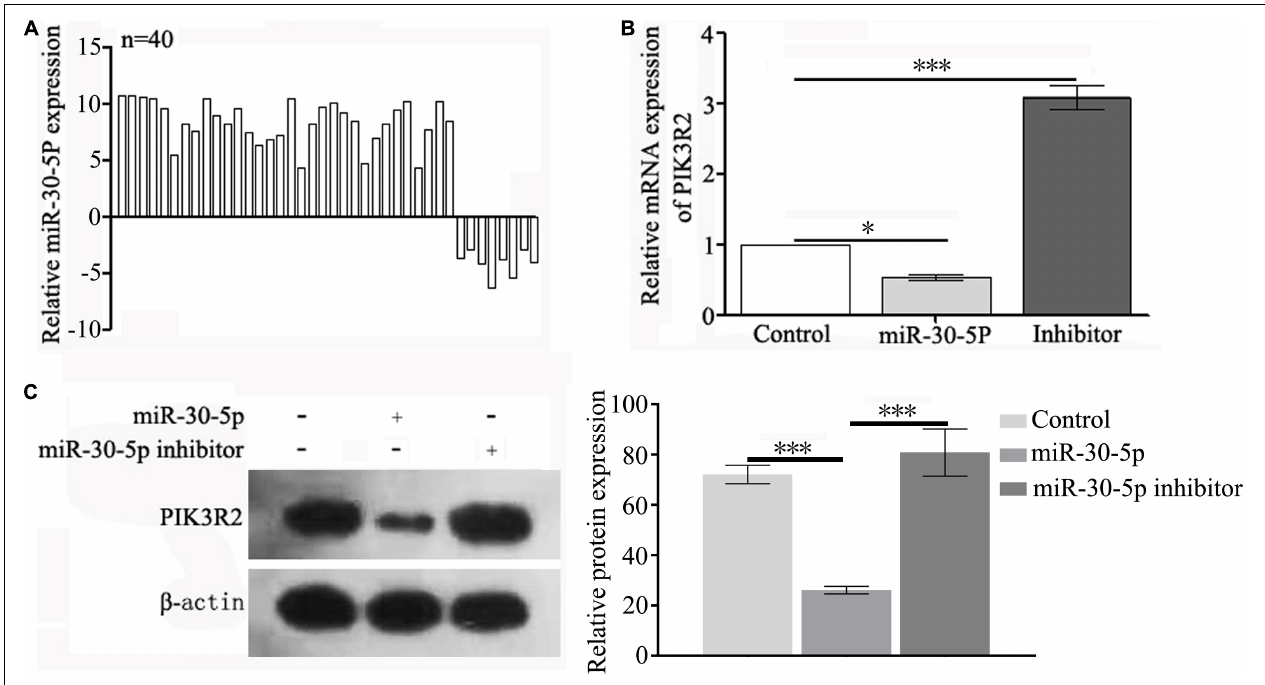
FIGURE 1 | miR-30-5p is overexpressed in RA clinical tissues and regulates the expression of PIK3R2 in the studied cell lines. (A) Relative mRNA expression of miR-30-5p in samples from 40 patients (28 males and 12 females) undergoing surgery was tested by qPCR. (B) Relative mRNA expression of PIK3R2 in HFLS cells transfected with miR-30-5p or miR-30-5p inhibitor, as determined by qPCR. (C) Protein expression of PIK3R2 in HFLS cells transfected with miR-30-5p or miR-30-5p inhibitor, as determined by Western blotting. Experiments in (B,C) were repeated three independent times ( ∗ p < 0.05, ∗∗ p < 0.01, and ∗∗∗ p <